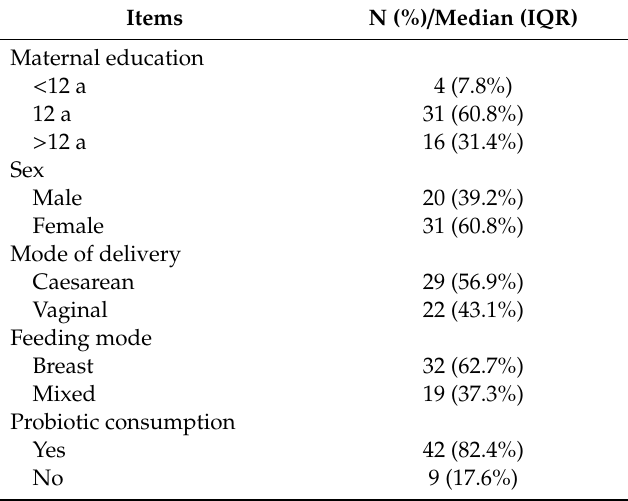
Table 1. Demographic and birth characteristics ( N =